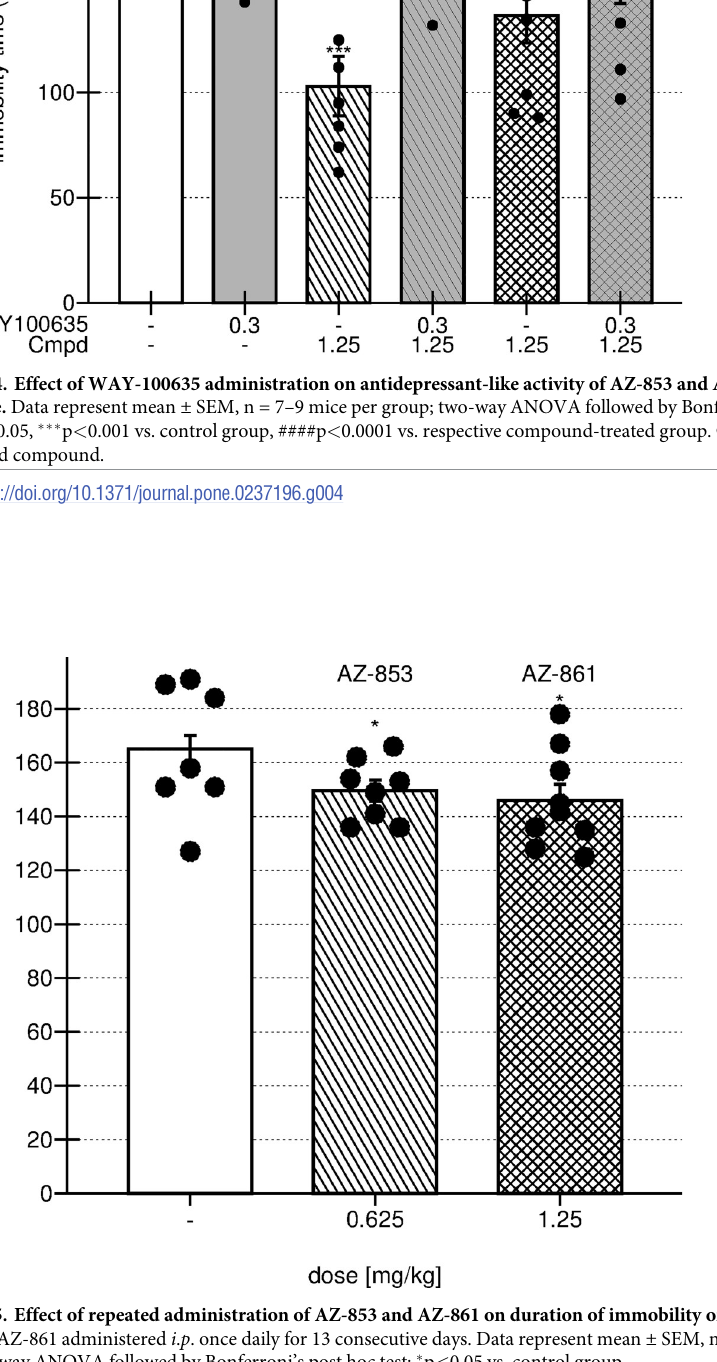
PLOS ONE | https://doi.org/10.1371/journal.pone.0237196 August 7,